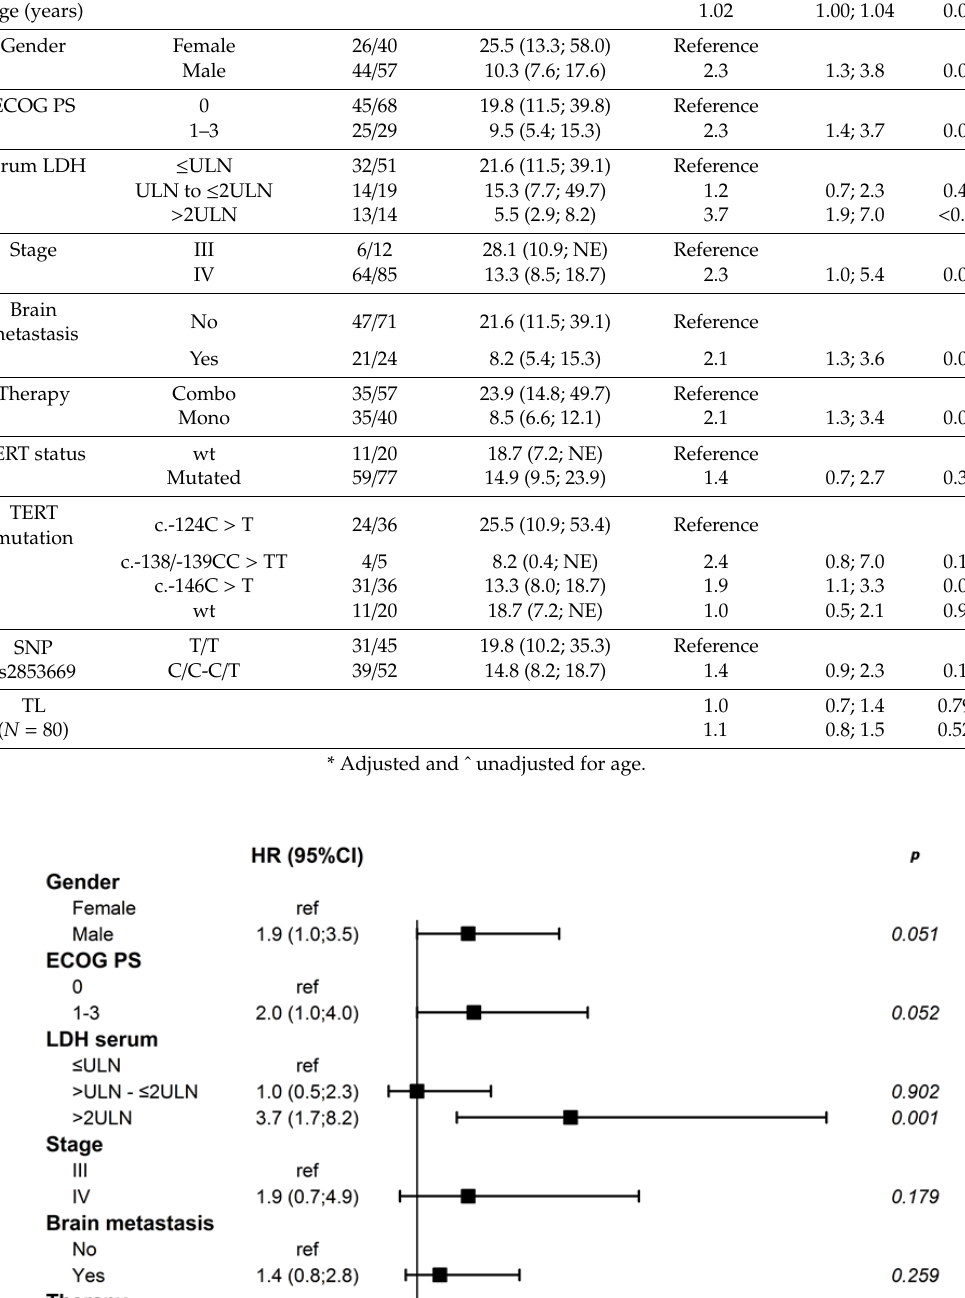
Table 3. Univariate Cox proportional hazards models of overall survival.